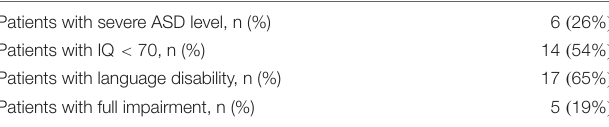
TABLE 2 | ASD level, IQ, and language disability. Patients with severe ASD level, n (%) 6 ( 26%